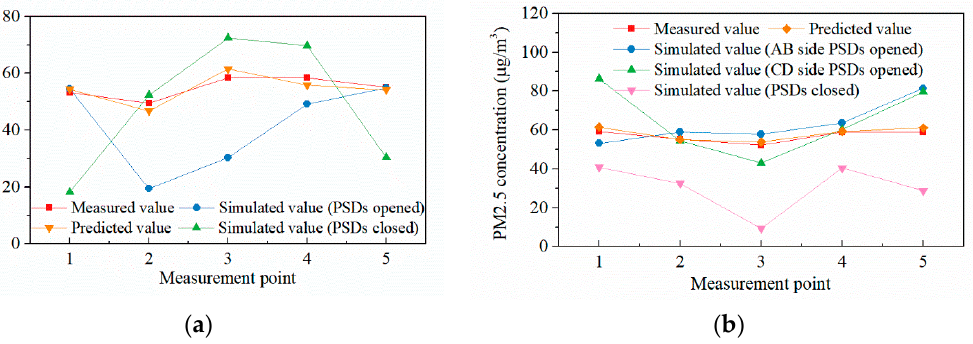
Figure 23. Comparison of PM2.5 concentration simulated results with measured results at measure- ment points: ( a ) Concourse floor; ( b ) Platform floor.